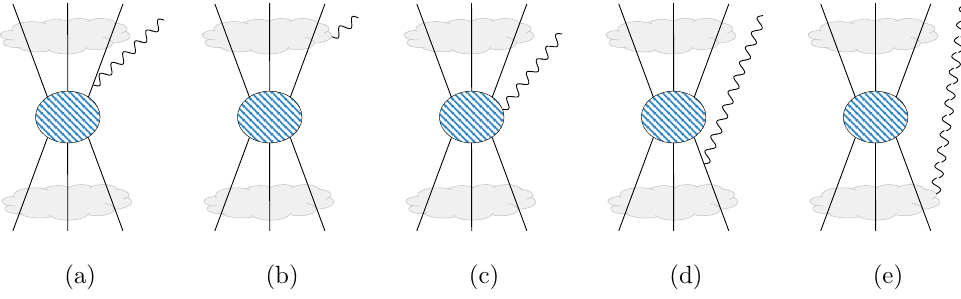
Figure 1. Different contributions to the emission amplitude of a soft